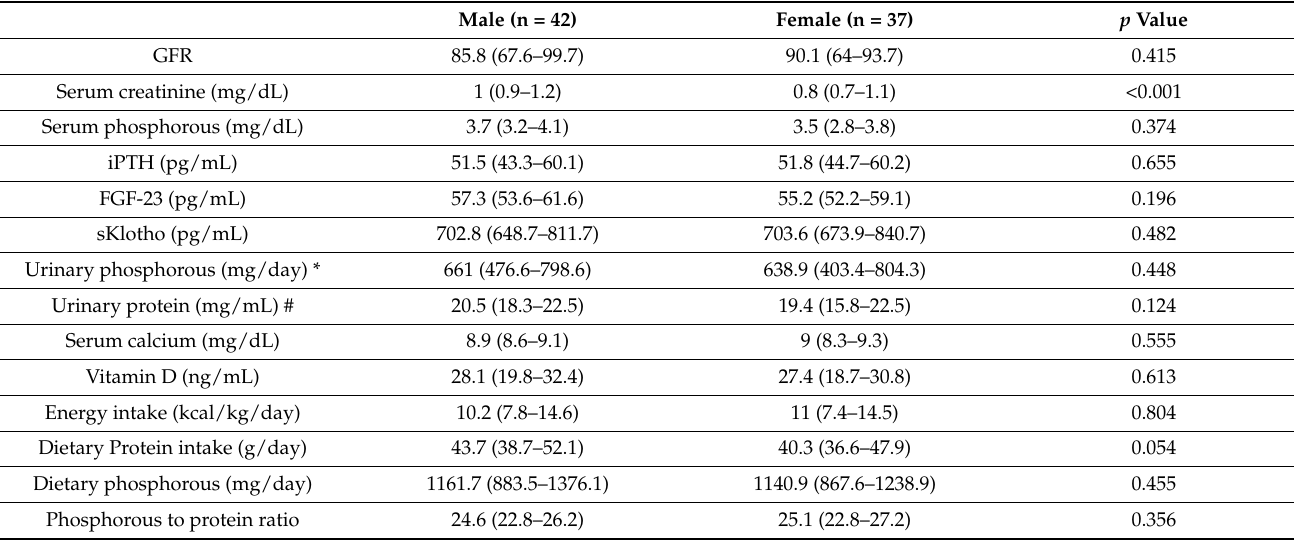
Table 5. Demographic and baseline biochemical data of the CKD patients based on